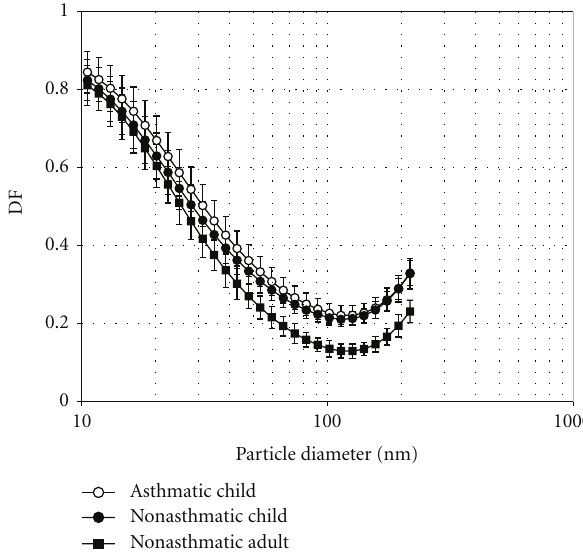
Figure 2: Measured deposition fraction curves for all subjects. Error bars represent 95% confidence intervals. The DF curves show a significant di ff erence between children and adults and a nonsignificant di ff erence between asthmatic and non-asthmatic